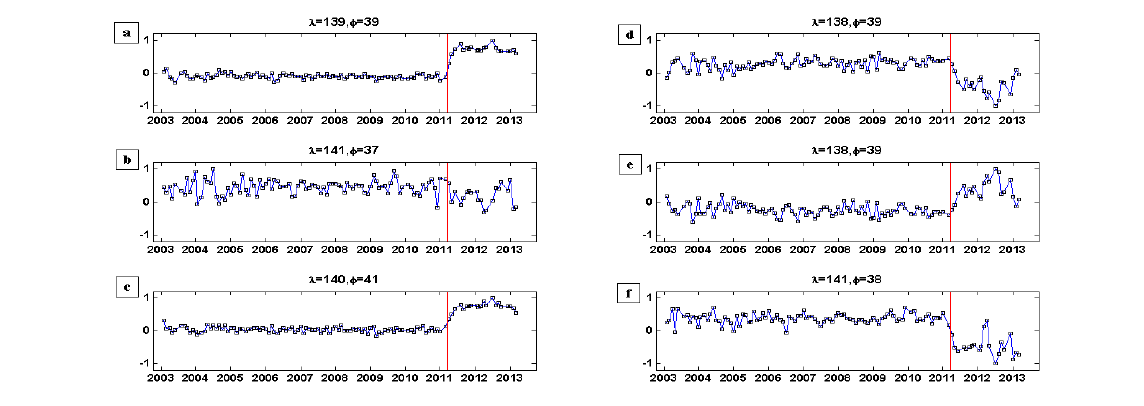
Figure 4. GRACE non-seasonal gravitational gradient change without applying any de-striping or spatial smoothing filter for component a) ΔV xx , b) ΔV xy , c) ΔV xz , d) ΔV zz , e) ΔV yy , and f) ΔV yz . Seasonal (annual and semiannual and S2 tidal wave) signals are removed from time series using least squares. The red line represents the time of Tohoku-Oki